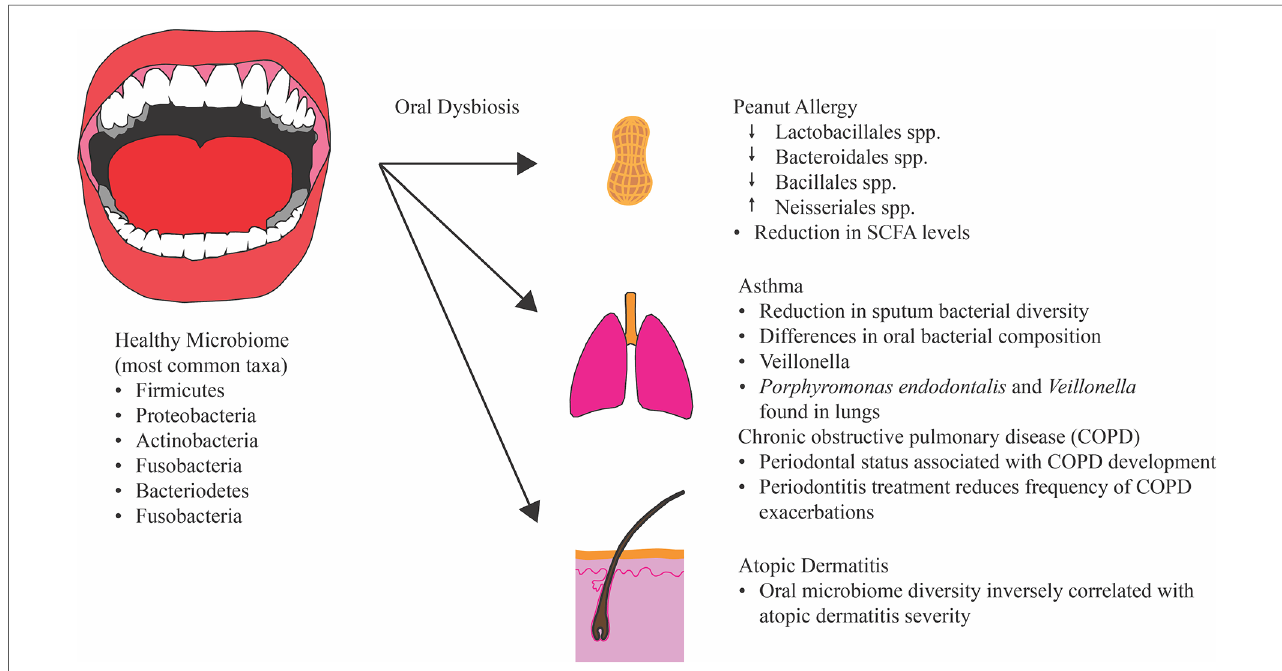
FIGURE 3 Alterations in oral microbiota composition is associated with allergic and respiratory diseases. Disruptions in oral microbiota composition have been associated with peanut allergy, asthma, chronic obstructive pulmonary disease, and atopic dermatitis, suggesting oral microbiota have an immunomodulatory role with allergy and respiratory